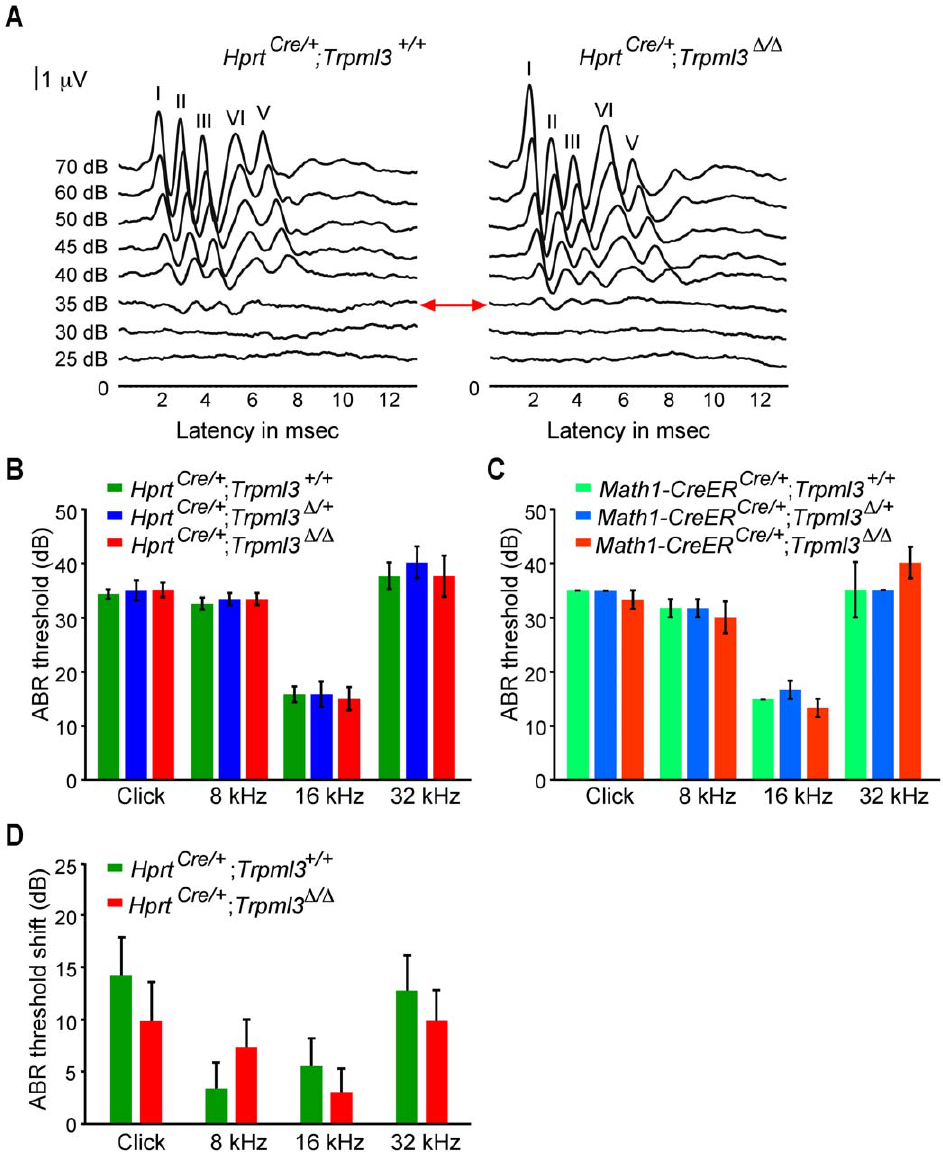
Figure 4. ABR measurements. A, Graph shows representative ABR waveforms of 3-week-old Hprt Cre/ + ; Trpml3 + / + and Hprt Cre/ + ; Trpml3 D / D mice in response to a click stimulus. ABRs were recorded at sound stimulation intensities of 25–70 dB. ABR waves I–V are indicated above the peaks. Red arrow highlights the hearing threshold, which is at 35 dB in this representative example pair. B, Shown are ABR thresholds (mean values 6 SEM) to click, 8-, 16-, and 32 kHz stimuli of Hprt Cre/ + ;Trpml3 + / + (n=6), Hprt Cre/ + ;Trpml3 D / + (n=6), and Hprt Cre/ + ;Trpml3 D / D (n=6) and C, of Math1-CreER Cre/ + ; Trpml3 + / + (n=3), Math1-CreER Cre/ + ;Trpml3 D / + (n=3), and Math1-CreER Cre/ + ;Trpml3 D / D (n=3), respectively. Statistical comparisons of means of different genotypes were made using one-way ANOVA followed by Tukey’s post test; p . 0.05. D, ABR threshold shifts of 3-month-old Hprt Cre/ + ;Trpml3 + / + (n=7) and Hprt Cre/ + ;Trpml3 D / D (n=7) 1 week after the acoustic overexposure of 125 dB SPL at 4 kHz for 4 hr. Shown are mean values 6 SEM. No significant differences were observed between genotypes (p . 0.05, one-way ANOVA, followed by Tukey’s post test).